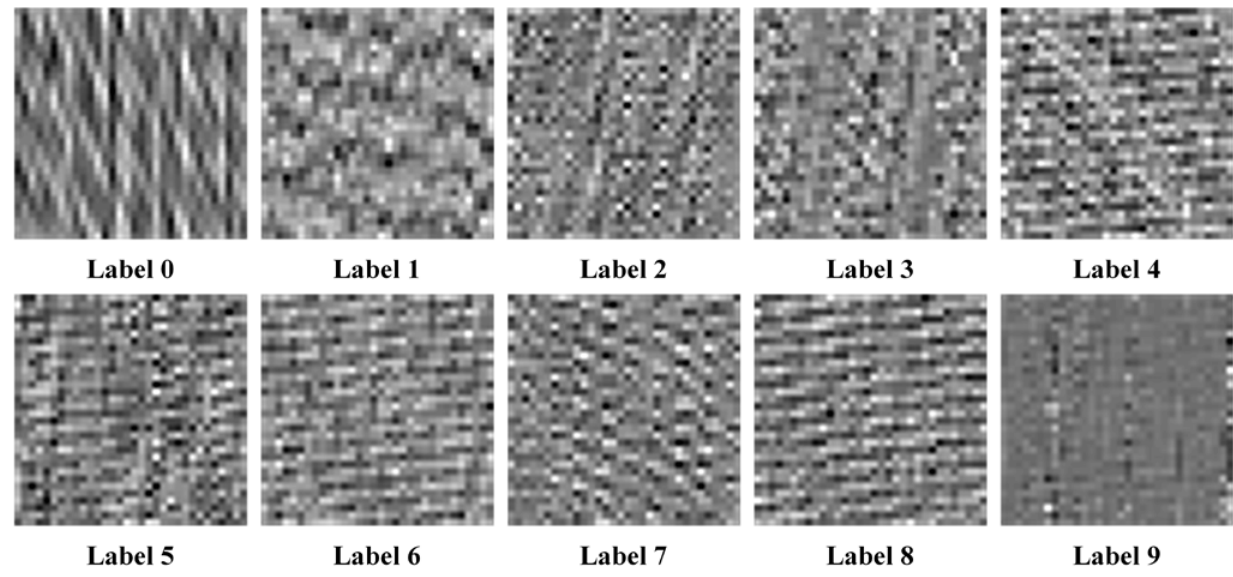
Figure 5. Converted grayscale images.